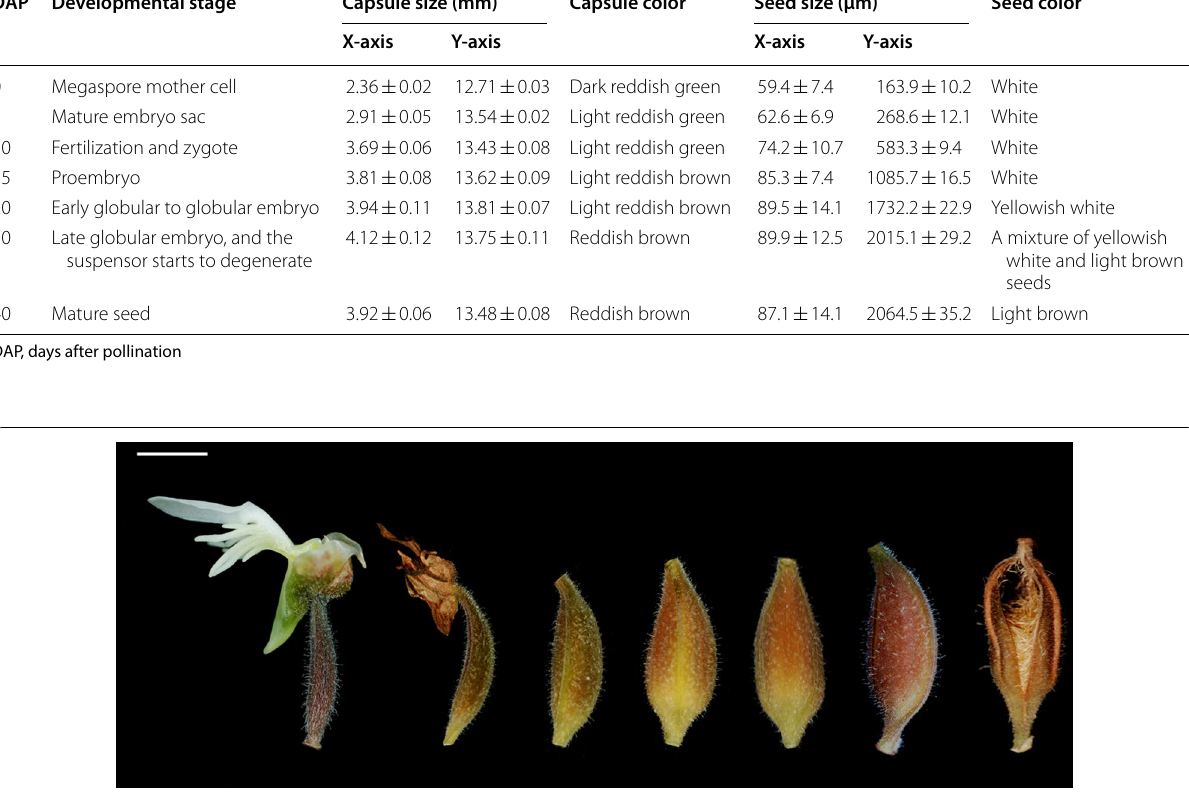
Fig. 2 Light micrographs of developing capsules of A. roxburghii . From left to right, 0, 5, 10, 15, 20, 30 and 40 DAP. Scale bar